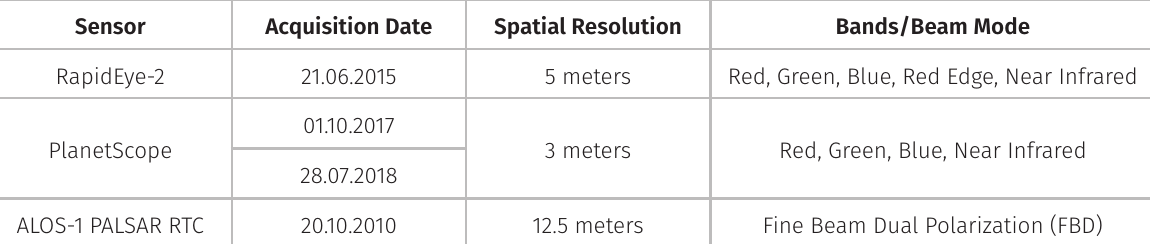
Table I. Remote sensing data used for semi-automated landslide